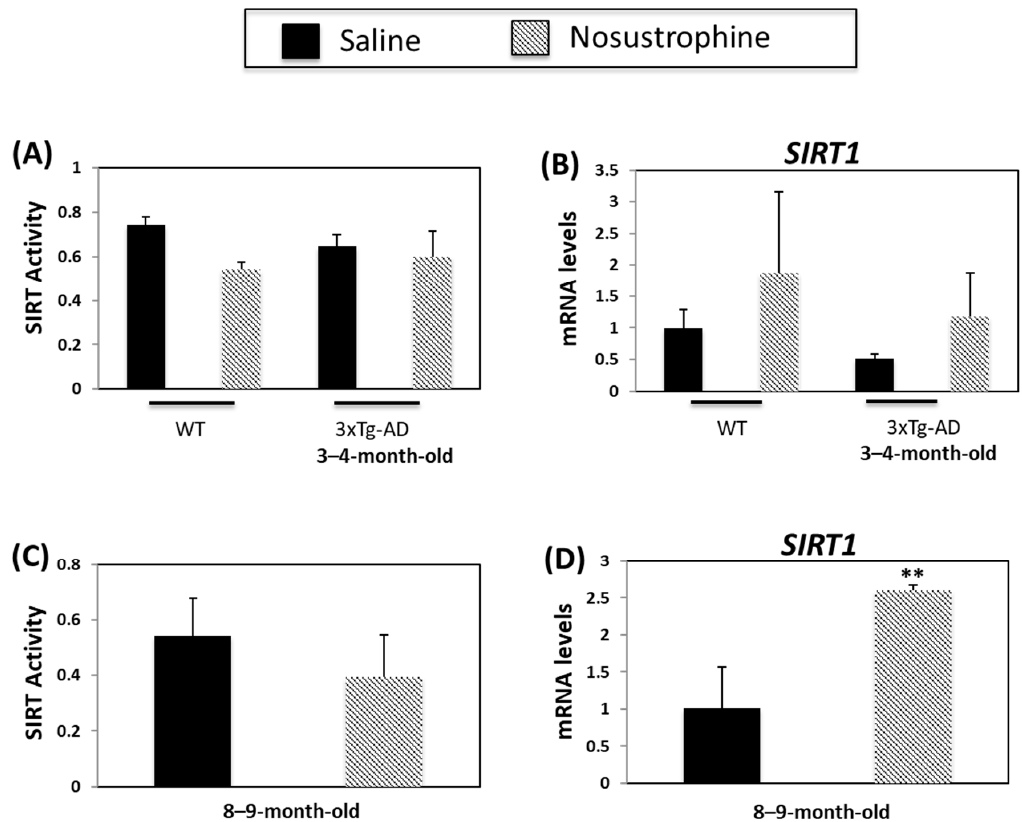
Figure 9. Nosustrophine regulates Sirtuin activity and SIRT1 expression. Sirtuin activity was mea- sured in wild-type and young (3–4-month-old) ( A ) and older (8–9-month-old) ( C ) 3xTg-AD mice ( n = 4 animals per group). SIRT1 mRNA levels were also measured by qPCR in wild-type and young ( B ) and old ( D ) 3xTg-AD mice. Results are expressed as fold-change compared to saline-treated wild-type- or trigenic mice. Data are expressed as means ± S.E.M. ** p < 0.01.